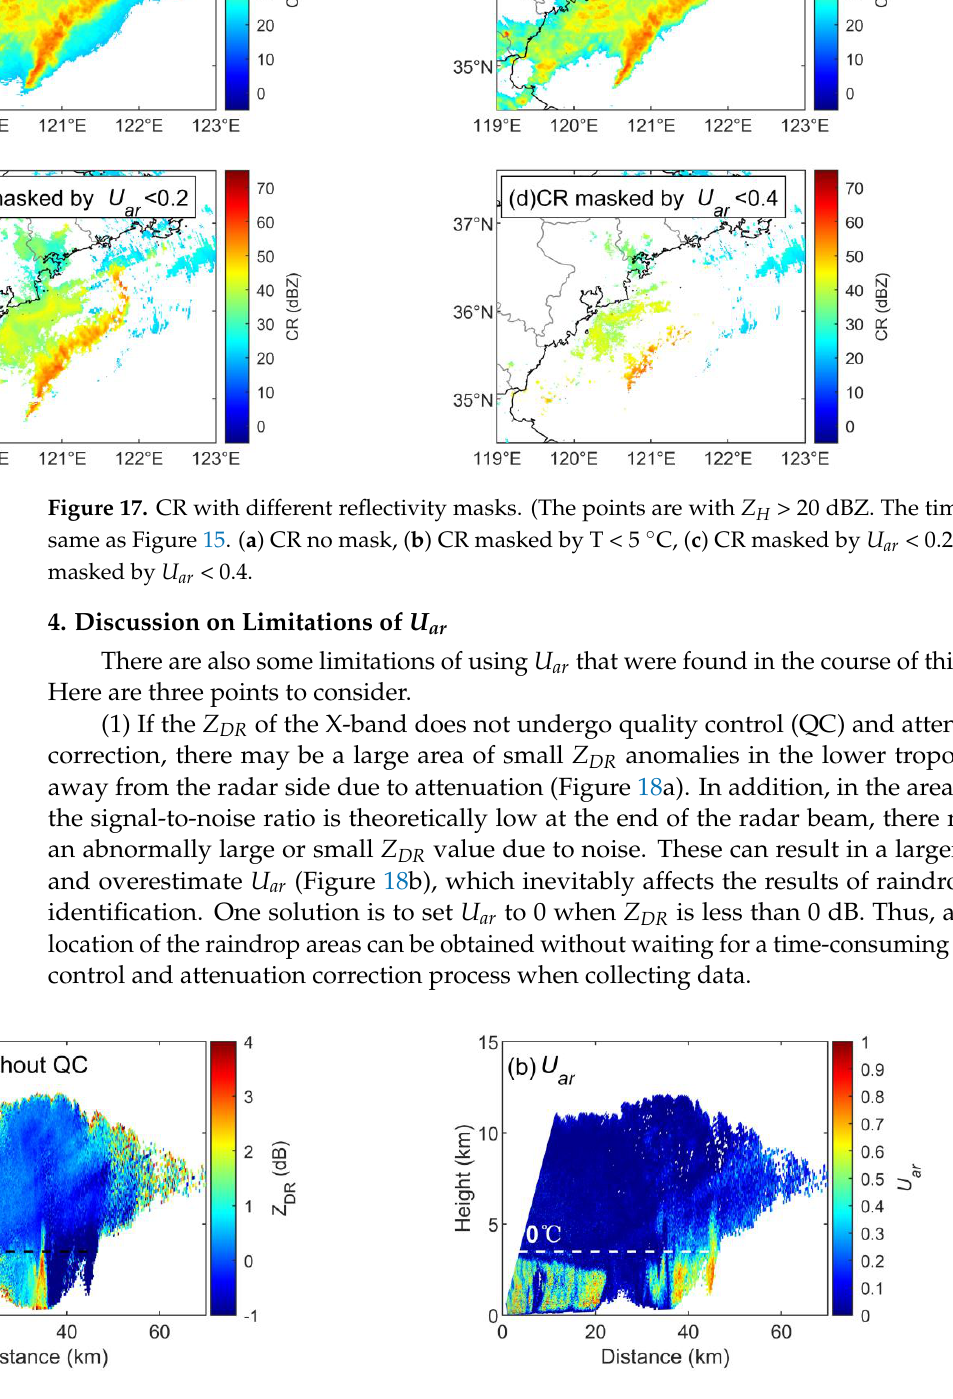
Figure 18. Sample of the impact on the U ar calculation without data quality control and attenuation correction for Z DR in the X-band. ( a ) Z DR without QC, ( b ) U ar